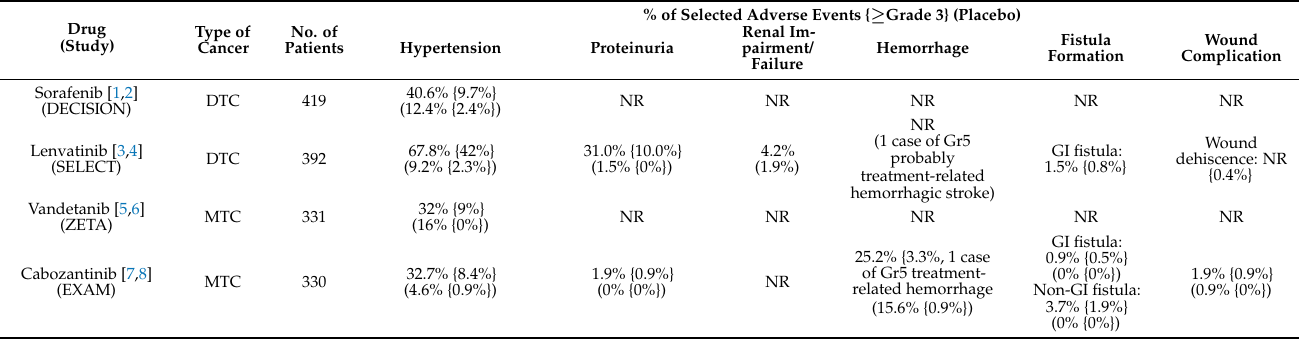
Figure 1. The concept of management of VEGFR-targeted TKI in thyroid cancer. AEs, adverse events. Table 1. AEs associated with VEGFR inhibition in phase III trials for advanced thyroid